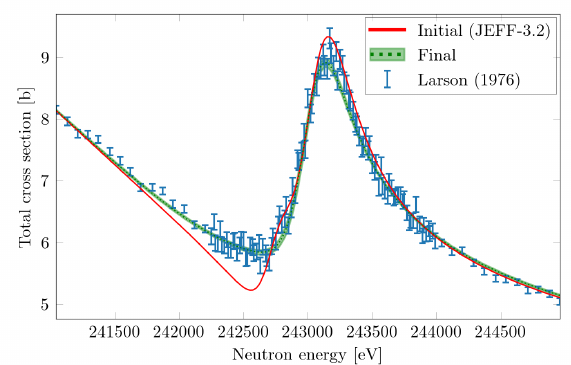
Figure 9. Resonance analysis using the JEFF-3.2 parameters.